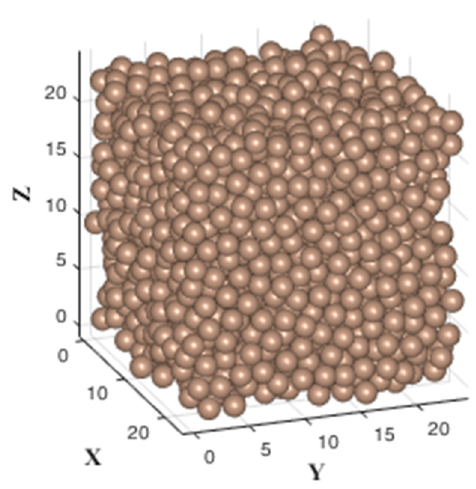
Figure 6. Random close packing algorithm visualization for a monodispersed set of 2000 spheres with a radius equal to 1.